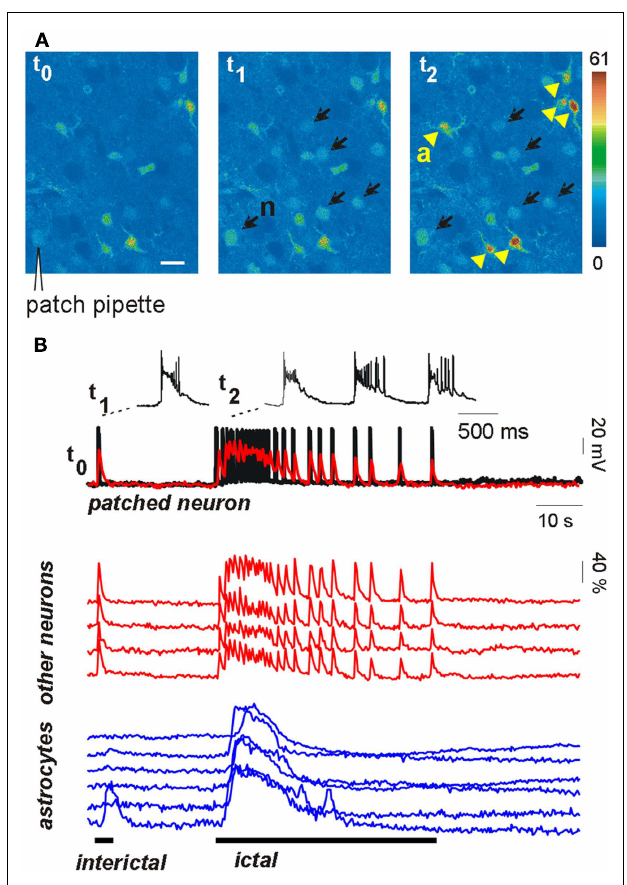
FIGURE 1 |Astrocytes are activated during focal seizure propagation in cortical slices. (A) Image sequence of the fluorescence signal change in layerV–VI neurons (n, black arrows) and astrocytes (a, yellow arrowheads) from the entorhinal cortex of a young rat after slice loading with the Ca 2 + dye Oregon-Green BAPTA1-AM during a propagating ictal discharge. (B) Simultaneous patch-clamp recording from one neuron [black trace; the patch-pipette is indicated in (A) ] and ∆ F / F 0 traces of the Ca 2 + signal in the same neuron (superimposed red trace) and other neighboring neurons (red traces) and astrocytes (blue traces).The Ca 2 + signal from all neurons precisely matched the electrical activity of the patched neuron during both the interictal event (single event at trace onset) and the subsequent ictal discharge. Astrocytes were strongly activated during the ictal discharge while they were poorly activated by the interictal discharge (adapted from Gomez-Gonzalo et al.,